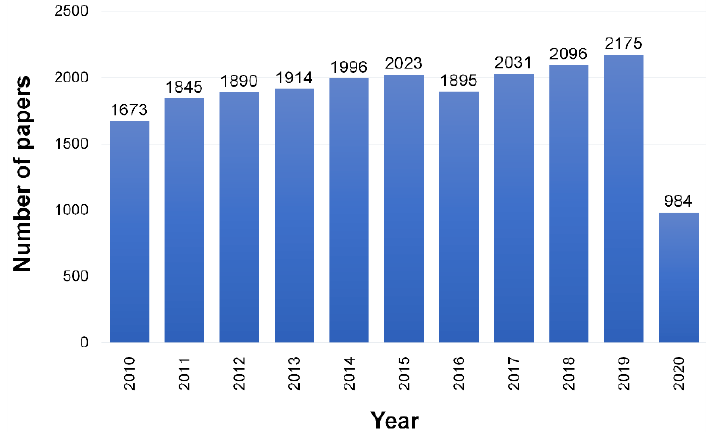
Figure 1. Number of papers published per year with the concept “Schiff base” in the title , abstract or keyword section according to Scopus document search in the period of the last 10 years (data retrieved